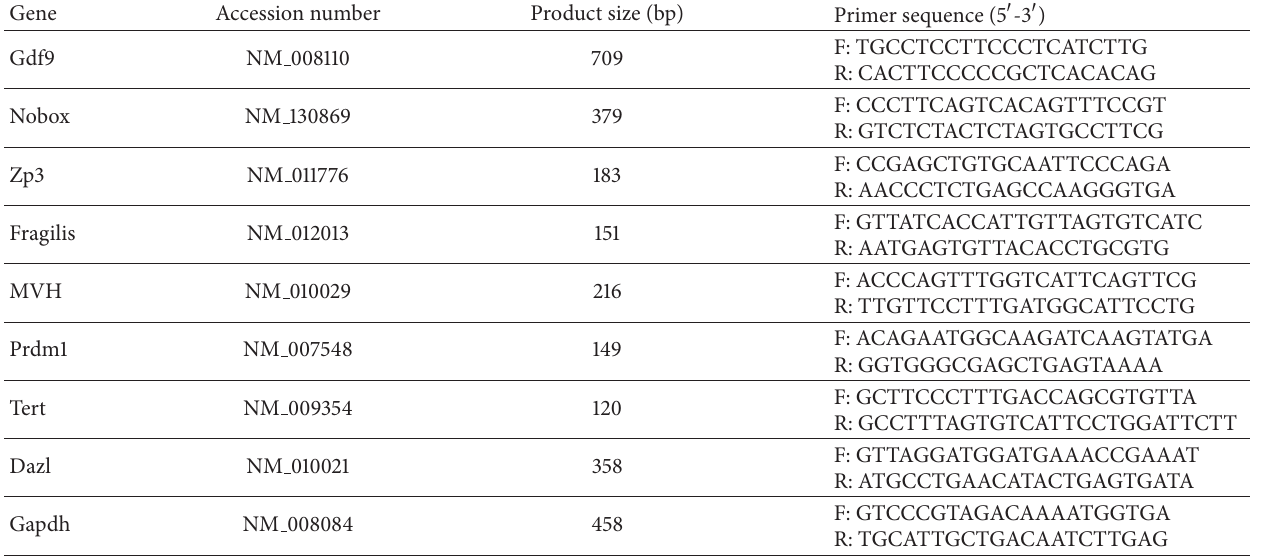
Table 1: Details regarding PCR primers used in RT-PCR for mouse ovary and